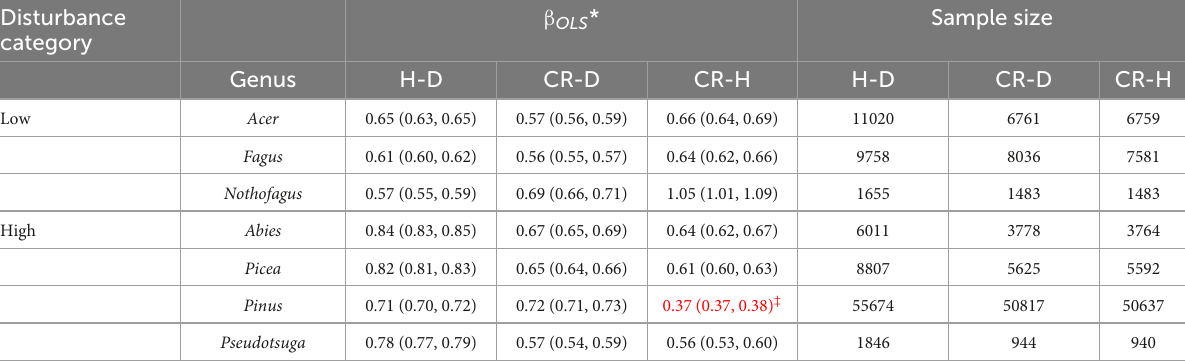
TABLE 4 Comparison of the phylogenetic allometry exponents ( β OLS ) of the stem height to diameter (H–D), crown radius to diameter (CR–D), and crown radius to stem height (CR–H) scaling in genera in high and low disturbance temperate forest biomes. Disturbance